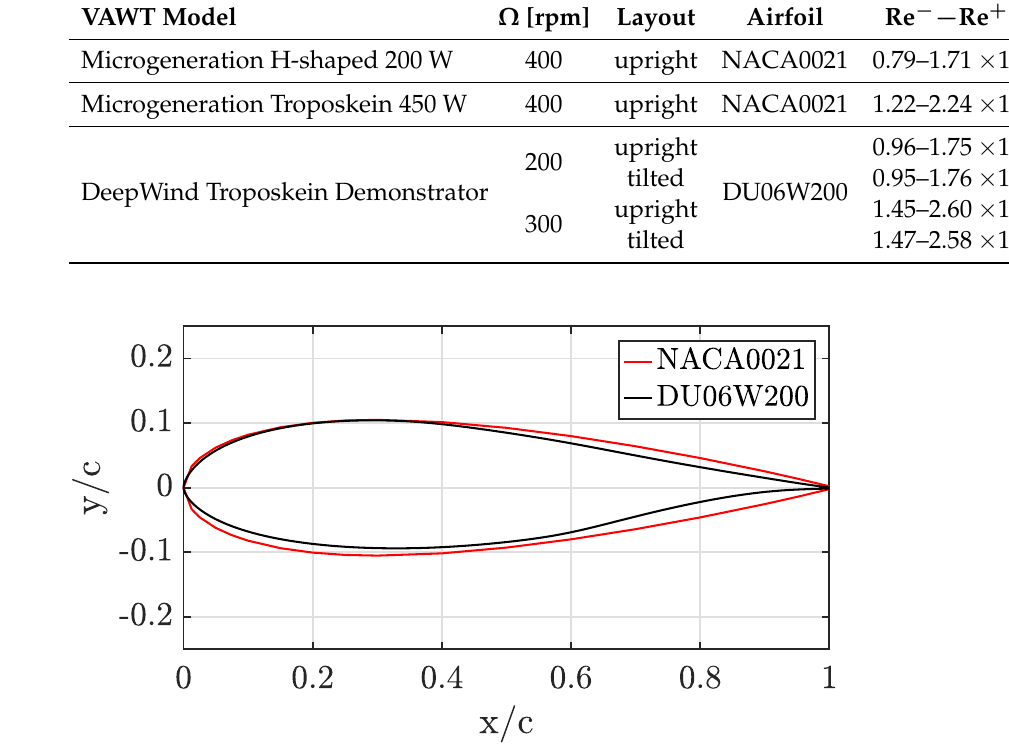
Figure 4. Airfoil